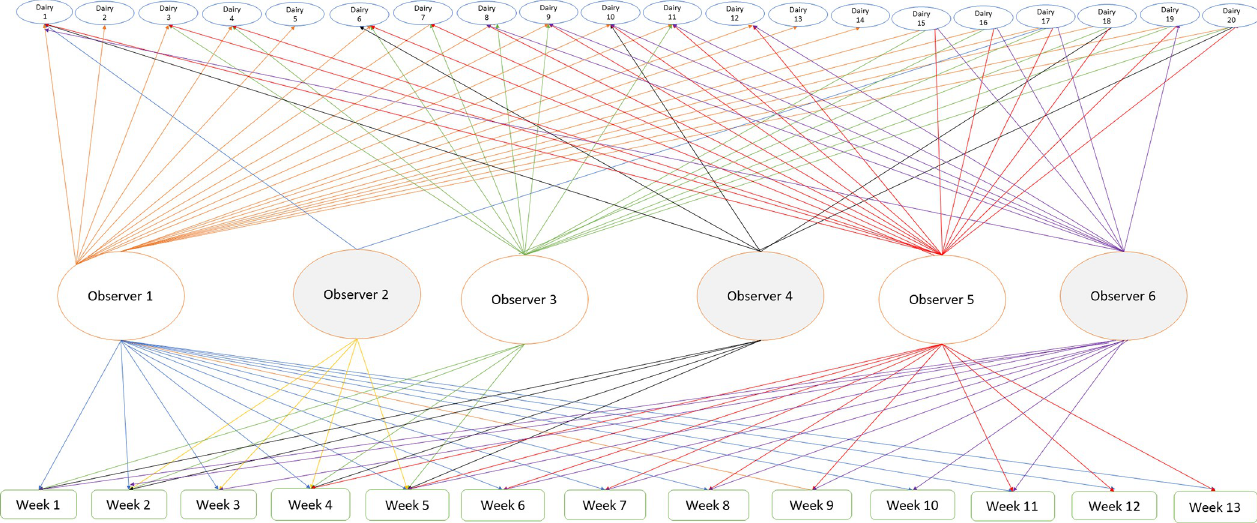
Fig 8. Schematic presentation of a longitudinal study of cow bunching at the dairy level using the average trap fly count. Dairies were crossed by observers and weeks. Crossing implies that the weeks of bunching observations, for example, were the same weeks on all the pens.